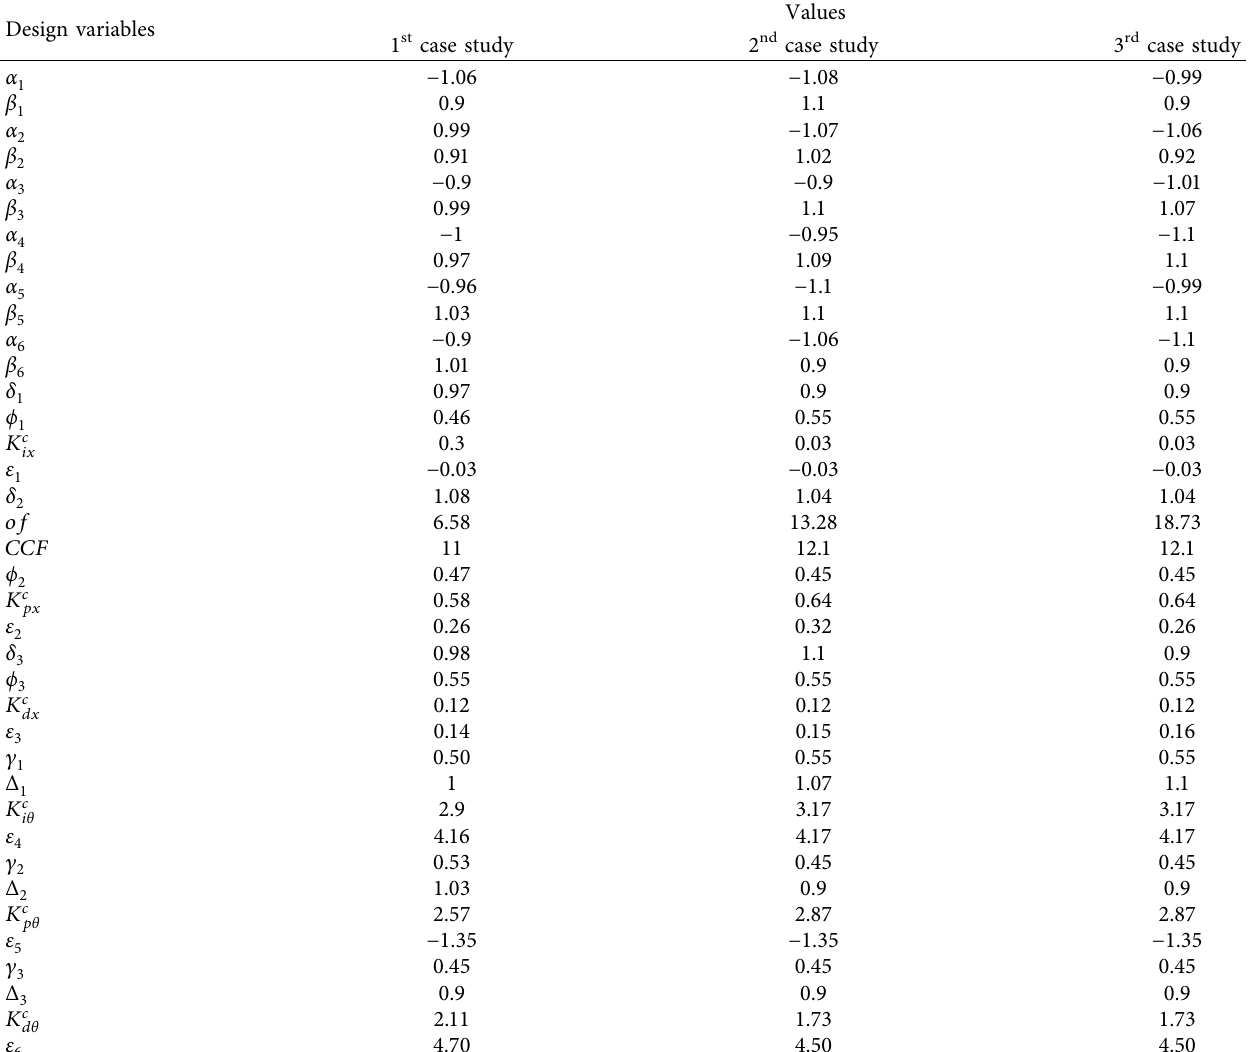
Figure 15: Control efforts based on the suggested fuzzy-PID controller and Yi and Yabazaki’s technique with [ 0 , 2 , 0 , 0 , π /6 , 0 ] initial Table 7: Design variables determined by means of the ICA for three case studies.